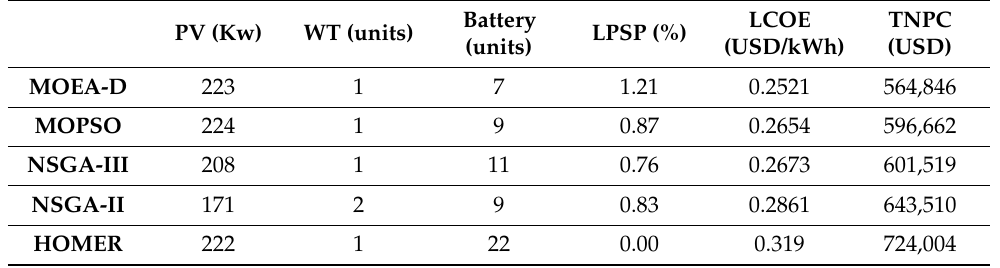
Table 5. LCOE Comparison between Proposed PVWB/EVCS System and Previous Studies. LCOE (USD/kWh) Source 0.2521